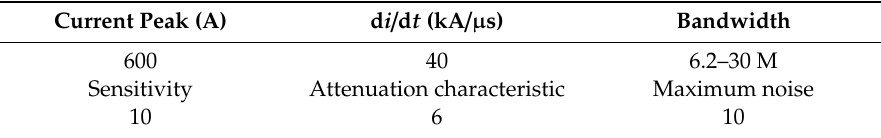
Table 4. Main parameters of the CWT Rogowski coil transducer.